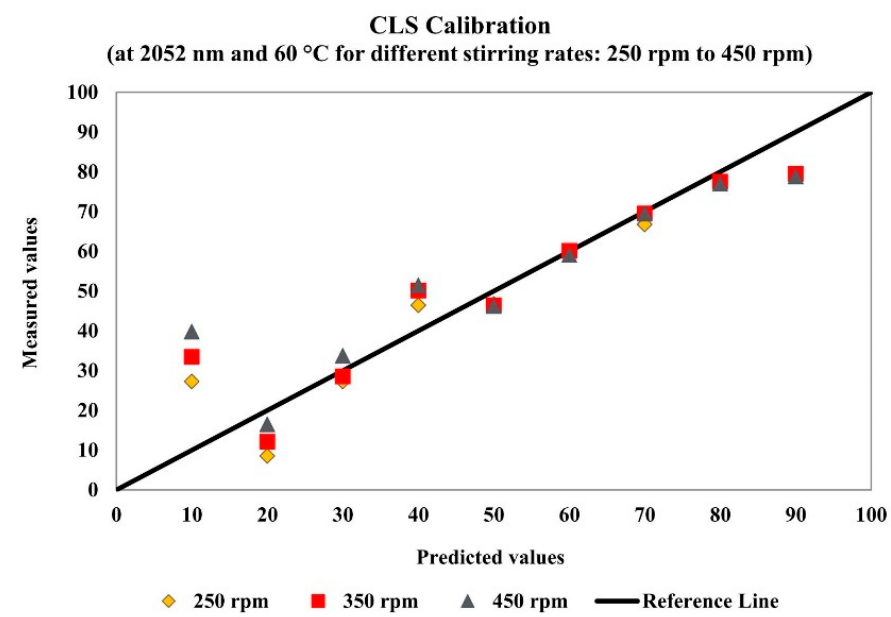
Figure 3. Simple linear calibration model performance at 2052 nm for temperature of 60 °C.